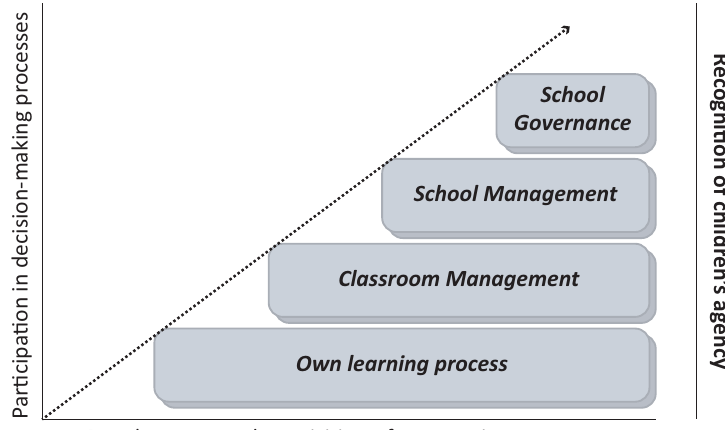
Figure 2. Schools as inclusive educational democratic communities or